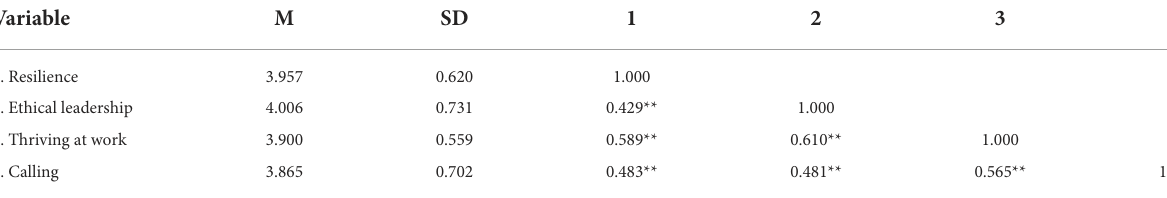
TABLE 1 Means, standard deviations (SDs), and correlations of continuous variables.